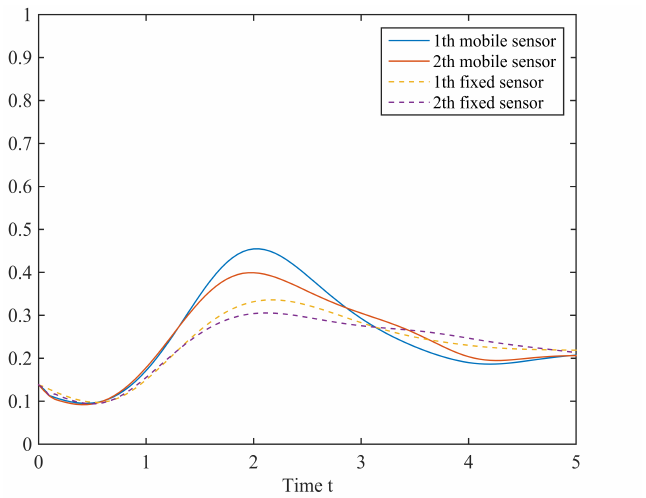
Figure 10. Evolution of spatial L 2